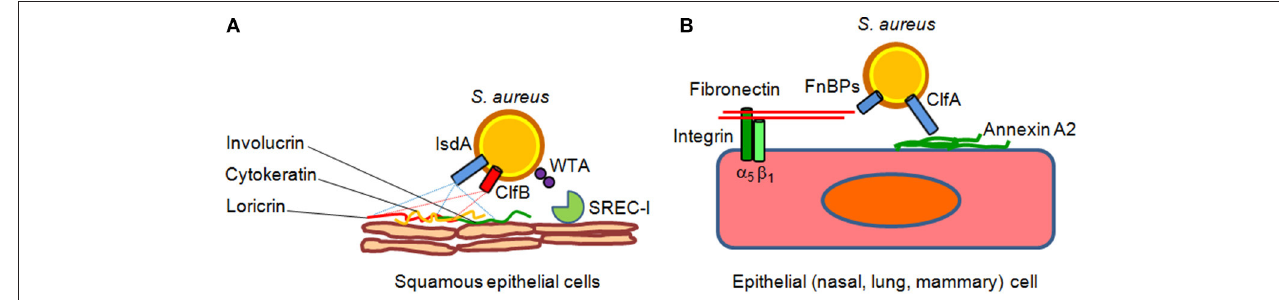
FIGURE 1 | Models of S. aureus adherence to and invasion of epithelial cells. (A) Adherence of S. aureus to epithelial cell surface is mediated by clumping factor B (ClfB) through high affinity interactions with cytokeratin 10 and loricrin. Iron-regulated surface determinant A (IsdA) protein further contributes to epithelial adherence by binding to the cornified cell envelope protein loricrin, involucrin and cytokeratin 10. Wall theicoic acid (WTA) glycopolymer has been also proposed to promote staphylococcal adhesion through an epithelial type F scavenger receptor named SREC-I. (B) Fibronectin-binding proteins A and B bind to the extracellular matrix fibronectin which interacts with integrin α 5 β 1 on the surface of epithelial cells, thereby triggering invasion of the cells. Recently, it has been suggested that clumping factor A (ClfA) bind to surface-associated annexin A2, and this interaction could mediate S. aureus internalization into mammary epithelial